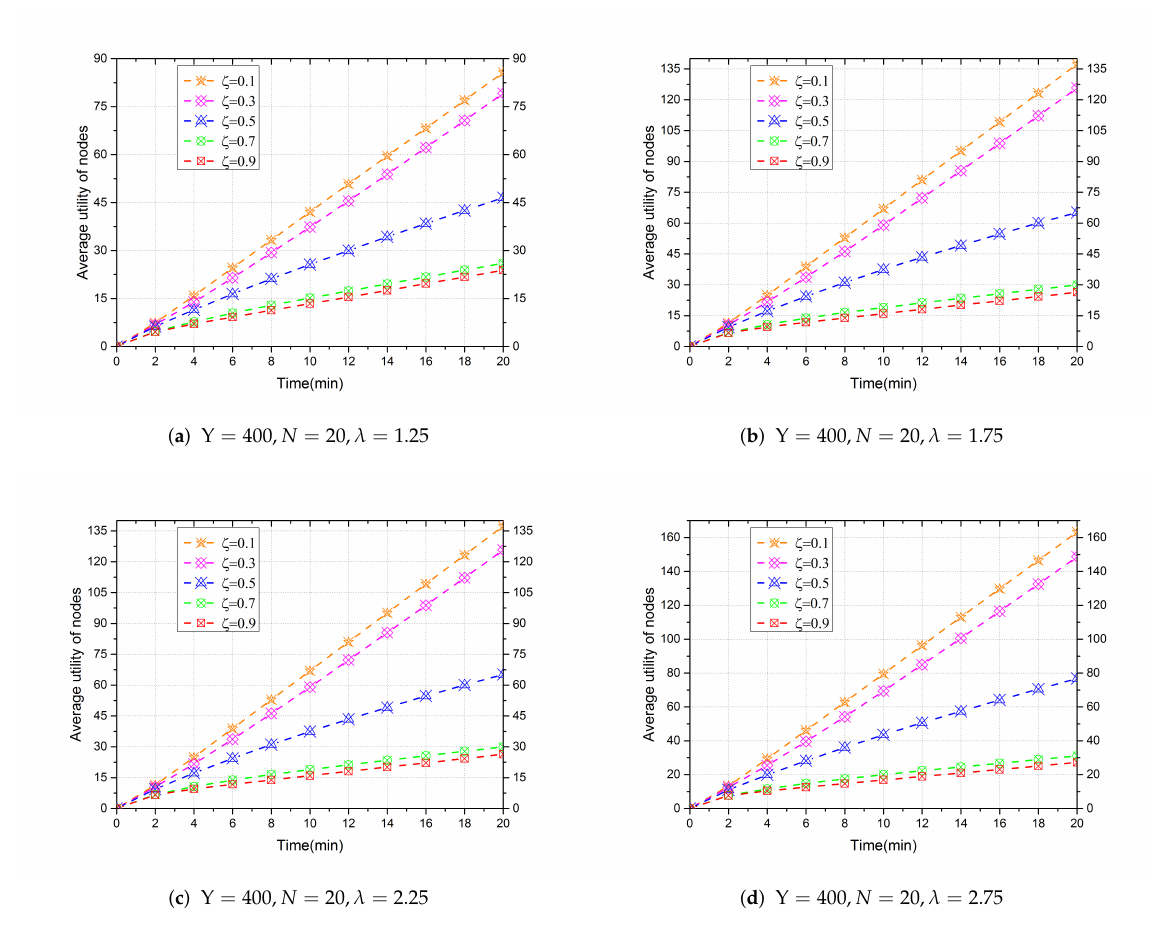
Figure 5. The influence of the ζ value on the average node